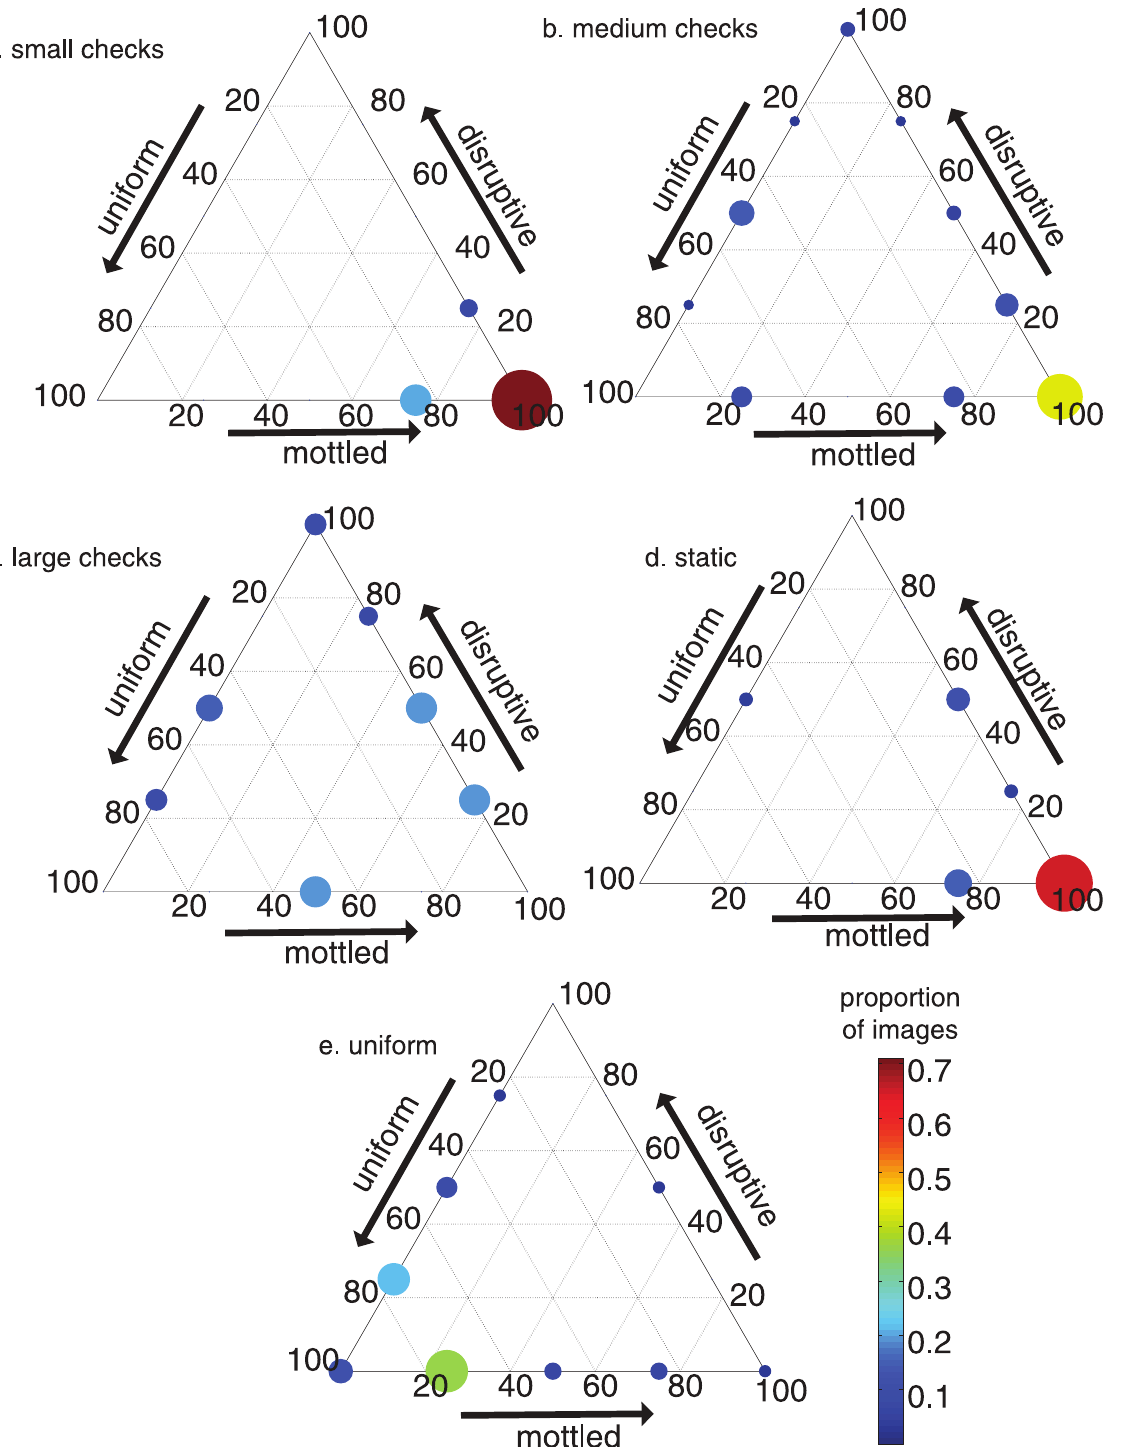
Fig 5. The classification of responses of cuttlefish exposed to different bottom stimuli. See text and Fig 4 for an explanation on how to read ternary plots. The larger the dot and warmer the color, the greater the proportion of images in that category. Proportion of cuttlefish images exposed to a bottom stimulus of (a) small checkerboard, (b) medium checkerboard, (c) large checkerboard, (d) television static, and (e), uniform.